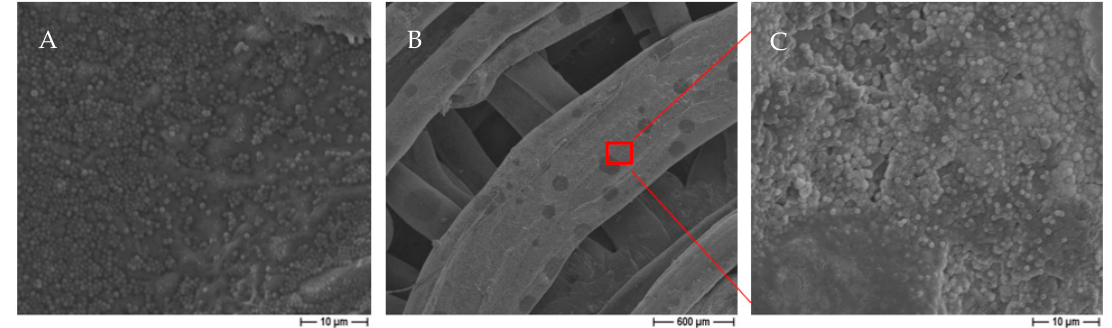
Figure 16. Micrographs of an Ag + -free hybrid sca ff old. ( A , C ) are high magnification of image ( B ): polymer ( A ) and ceramic ( C ) parts indicate bacterial biofilm on both